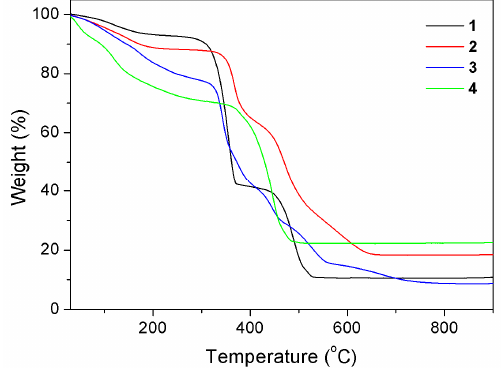
Figure 5. Thermogravimetric curves of compounds 1 − 4 .